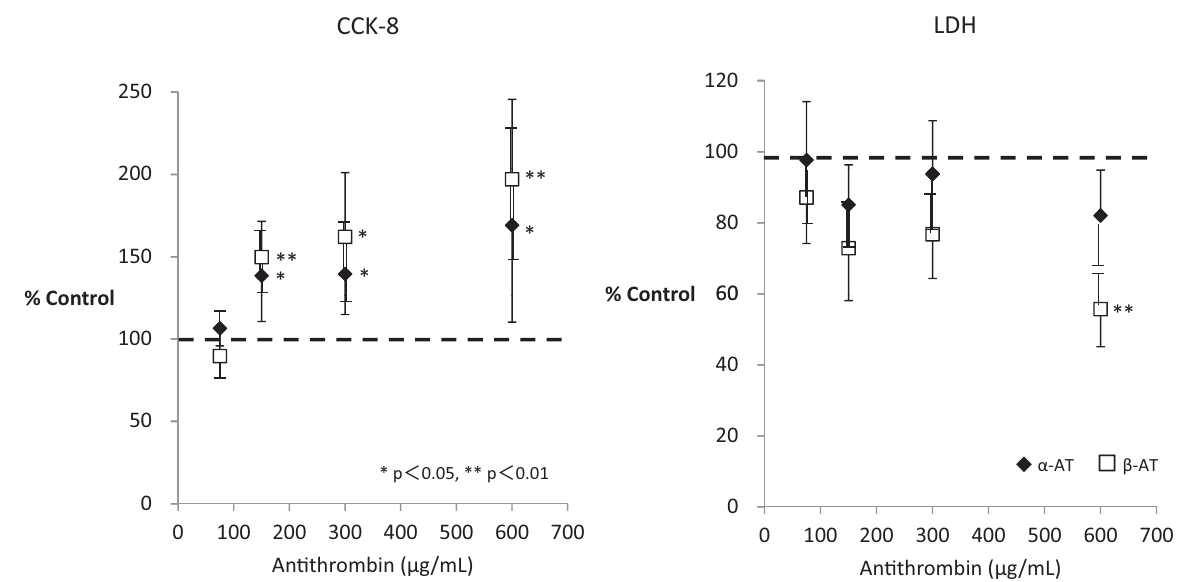
Fig. 2 Changes in cell viability and cellular injury after treatment with α - or β -antithrombin. Cell viability increased after treatment with antithrombin in a dose-dependent manner, and a signi fi cant increase was recognized when the α - or β -antithrombin dose was 150 μ g/mL or more. The increase in the lactate dehydrogenase (LDH) level was suppressed at a β -antithrombin dose of 600 μ g/mL. In contrast, the suppression was not signi fi cant after treatment with α -antithrombin. Data are expressed as the mean (cid:3) standard deviation. AT, antithrombin, (cid:4) p < 0.05, (cid:4)(cid:4) p < 0.01, compared with control.